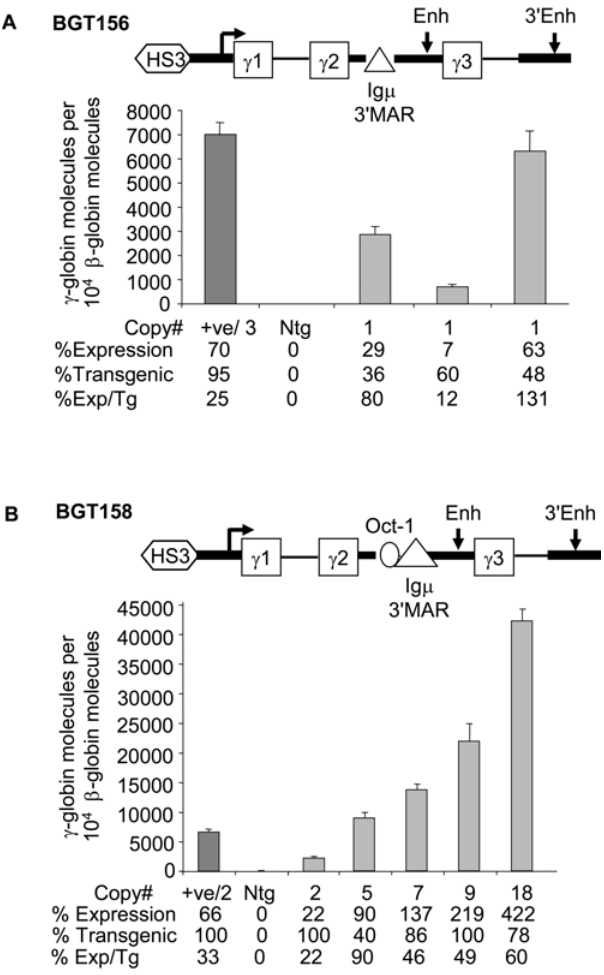
Figure 3. The Ig m 3 9 MAR rescues LCR activity but consistent expression levels requires the Oct-1 site. (A) qRT-PCR results from BGT156 transgenic animals show mean expression per transgene is 74% 6 34. (B) qRT-PCR results from BGT158 transgenic animals show mean expression per transgene is 53% 6 11. All samples analyzed as described in Figure 2, with the exception that the positive control ( + ve) in BGT158 is fetal liver RNA from a previously characterized bred homozygous BGT50 mouse